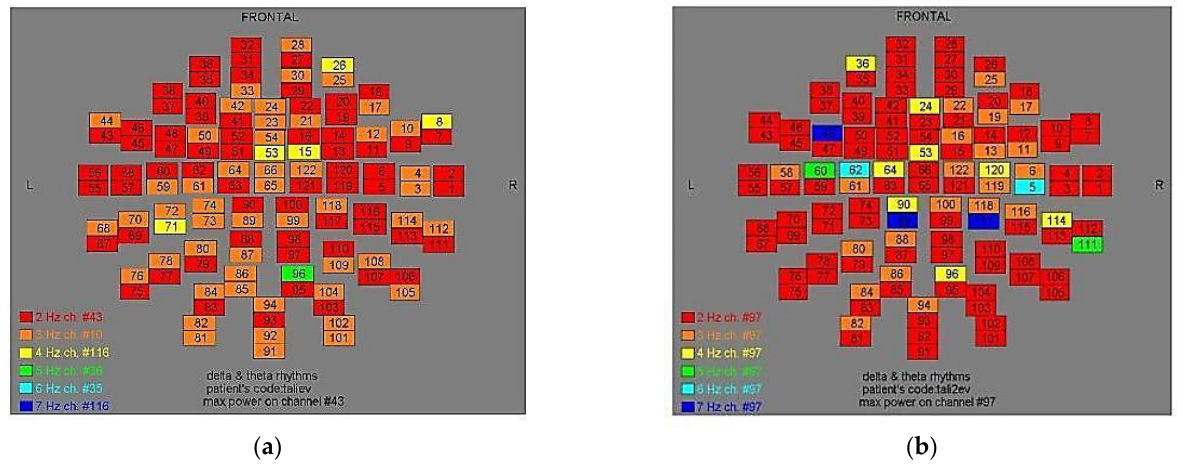
Figure 5. Dominant frequency color mapping for patient #4, before ( a ) and after ( b ) magnetic stimulation.